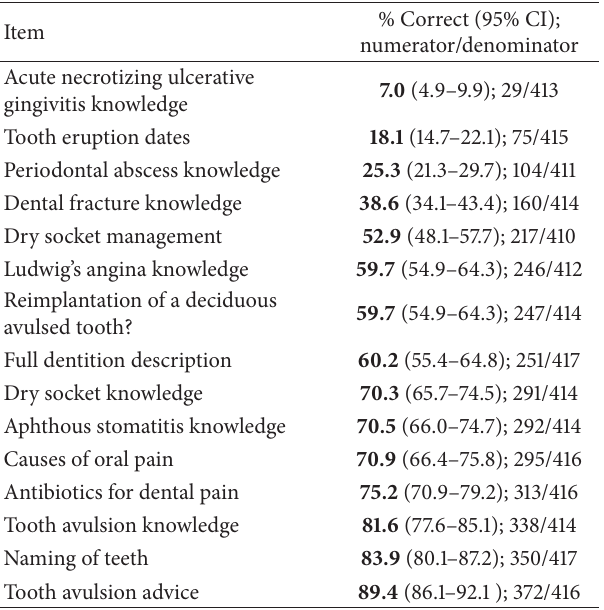
Table 2: Percentage (95% CI) of participants answering knowledge item